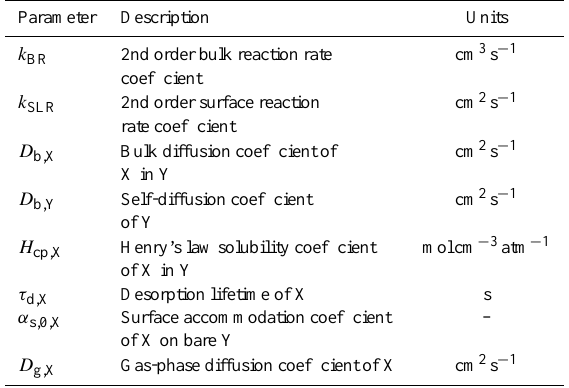
Table 2. Kinetic input parameters in the KM-SUB representation of aerosol